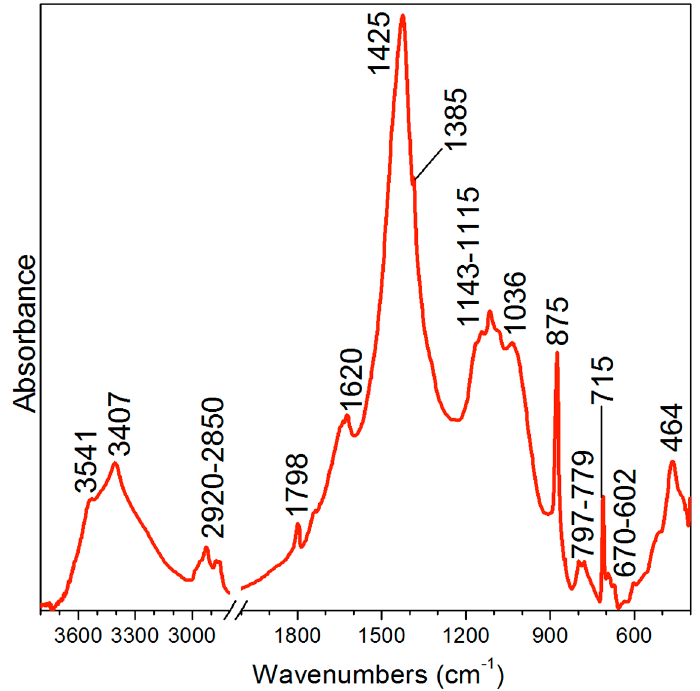
Figure 5. FTIR characterization of a representative deposit on stone specimen (site 2).